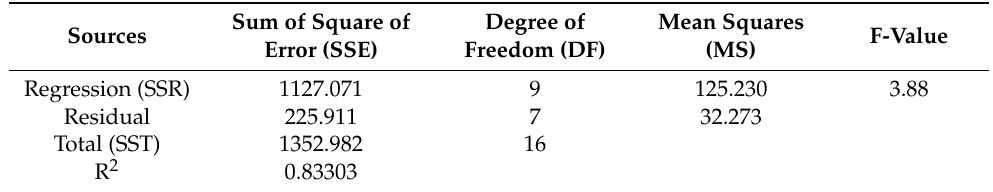
Table 3. ANOVA for prediction model of water removal response.